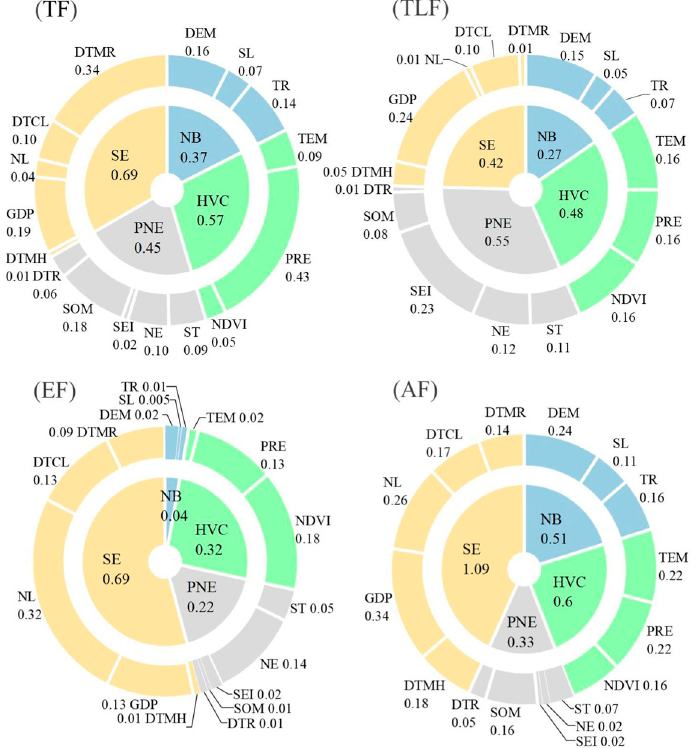
Figure 6. Distribution of q-values of factors influencing different karst trough valley types: NB: natural background; DEM: elevation; SL: slope; TR: topographic relief; SE: social environment; DTMH: distance to main highways; GDP: gross national product; NL: night lights; DTCL: distance to county location; DTMR: distance to main railways; HVC: hydrothermal vegetation condition; ST: soil type; NE: neighborhood enrichment; SEI: soil erosion intensity; SOM: soil organic matter; DTR: distance to rivers; PNE: production neighborhood environment; TEM: annual average temperature; PRE: annual average precipitation; NDVI: normalized difference vegetation index.